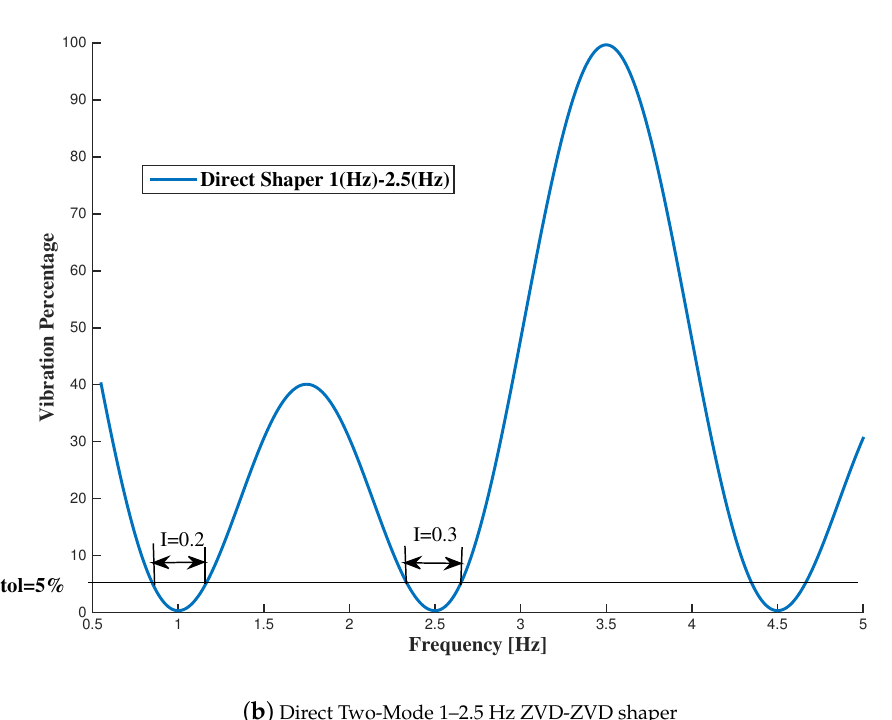
Figure 19. Convolved and Direct Two Mode ZVD-ZVD Shapers for 1 Hz and 2.5